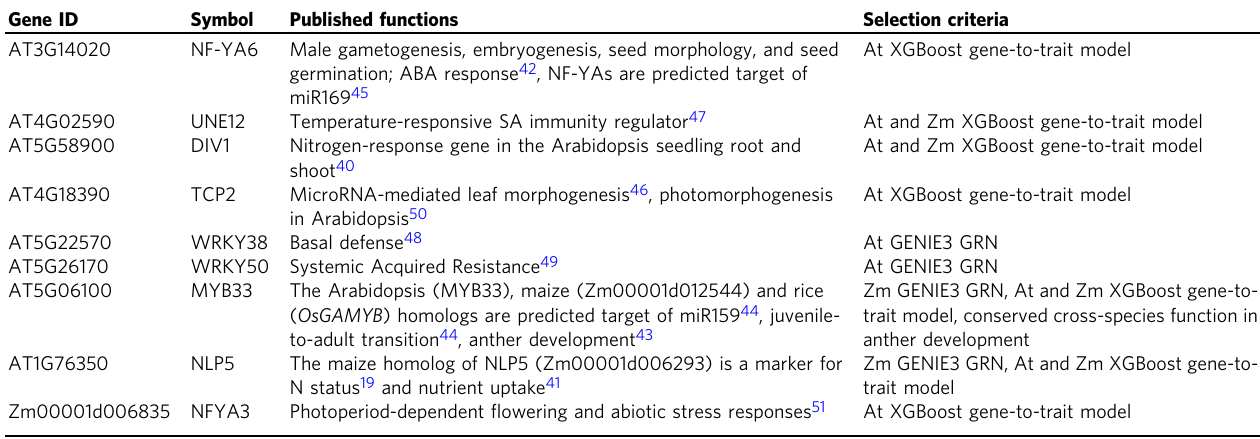
Table 2 Candidate TFs identi fi ed from XGBoost feature importance ranking for predicting NUE and/or hubs in GENIE3 network constructed from XGBoost important gene